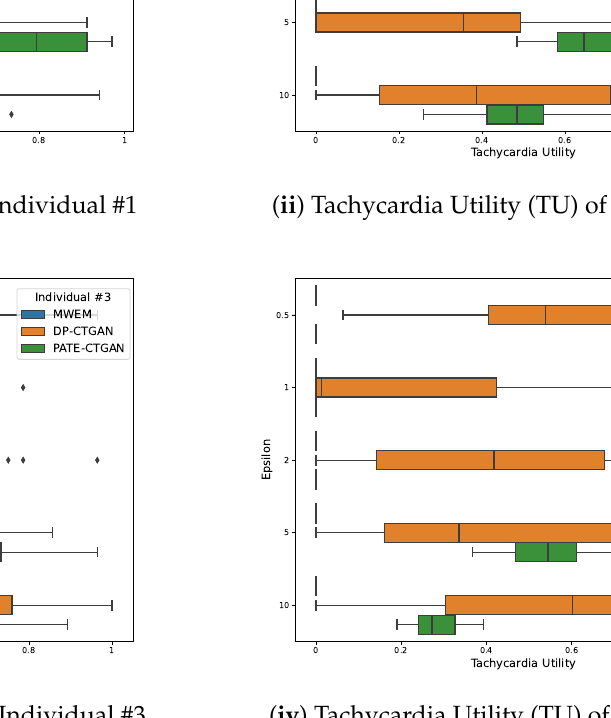
Figure 4. Box plots showing the Tachycardia Utility (TU) for four individuals using MWEM, DP-CTGAN, and PATE-CTGAN at 20 runs.